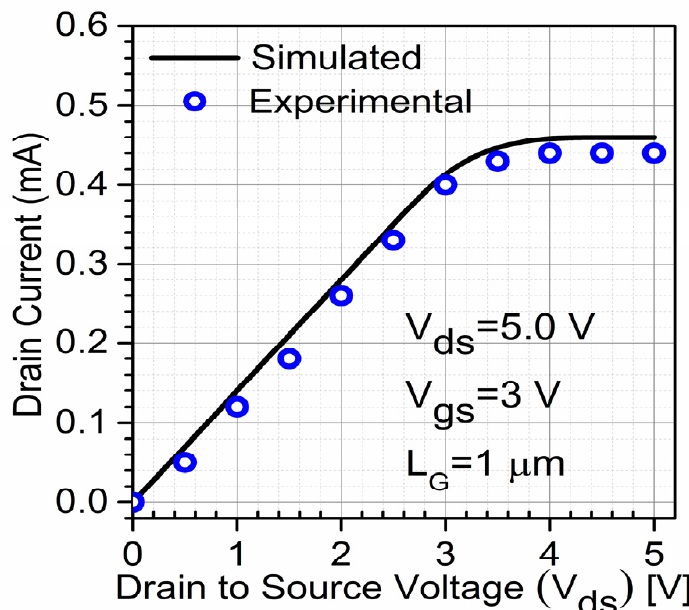
Figure 2. I ds -V ds characteristics calibration of experimental GaN FinFET [17].